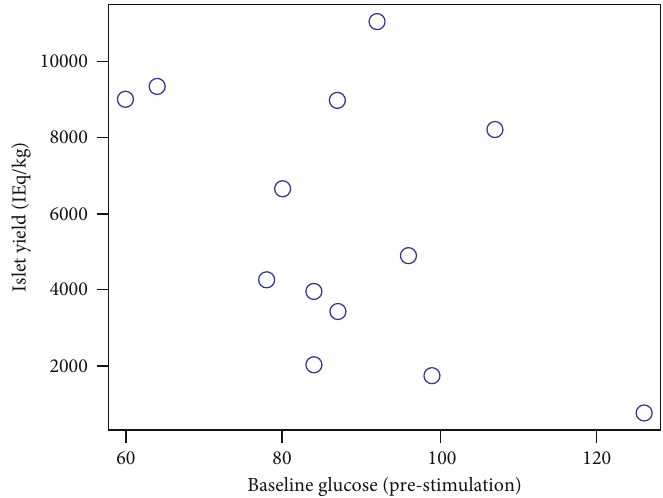
Figure 1: Preoperative baseline glucose prestimulation with glucose plotted against islet yield per kilogram (IEq/kg) intraoperatively. The analysis revealed no statistically signi fi cant correlation of islet yield (IEq/kg) with preoperative baseline glucose.